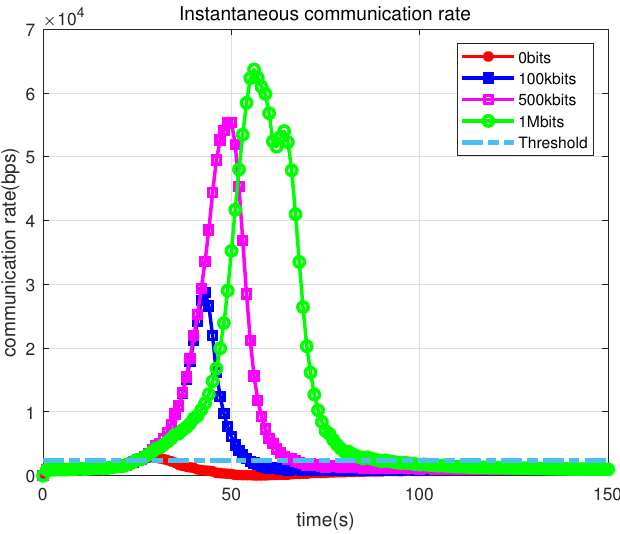
Figure 12. Instantaneous communication